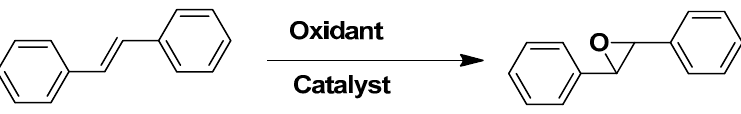
Figure 6. Schematic representation of the truncated octahedron polyhedral cages present in MMPF-3. Adapted from http://sqma.myweb.usf.edu/pages/publications.html#anchor2012.